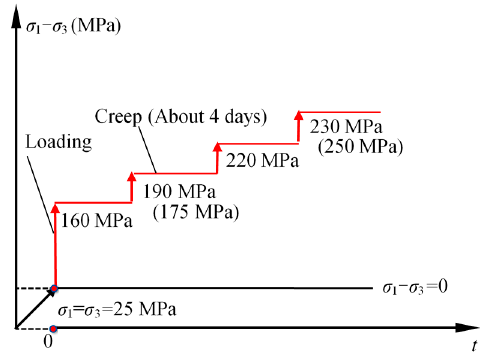
Figure 1. Loading procedure for creep tests.